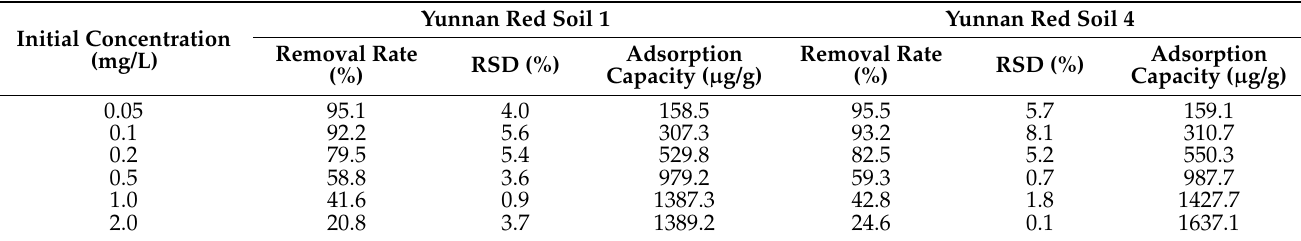
Table 2. Effect of Initial Arsenate Concentration on the Sorption of Arsenate.